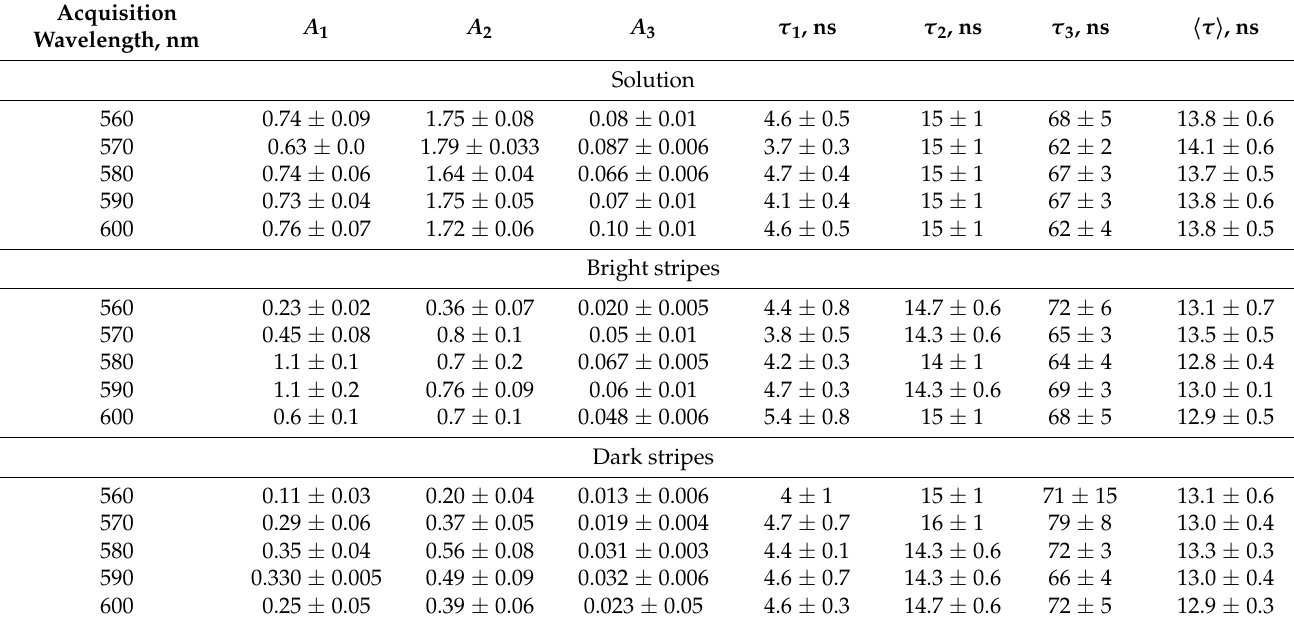
Table A1. QD PL decay parameters in the monomer solution, and the bright and dark stripes of a grating: amplitudes, decay times of three exponential components, and the average decay